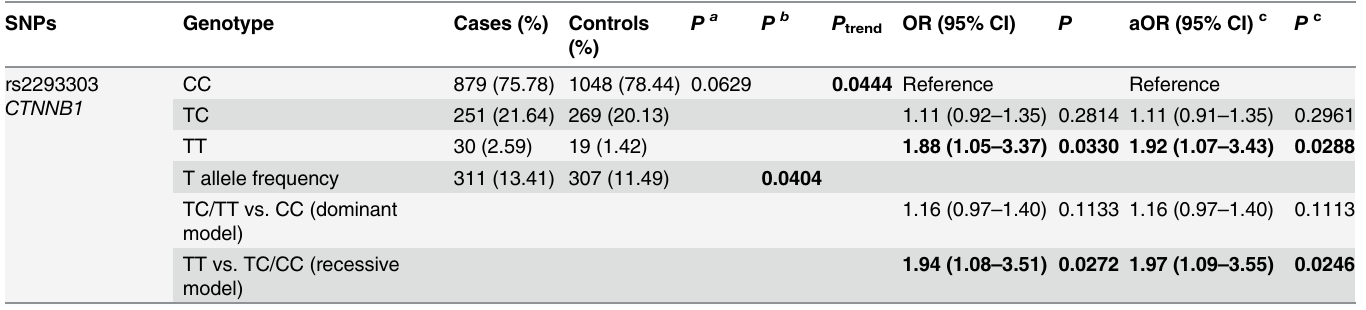
a Two-sided χ 2 test for difference in frequency distribution of genotypes between cases and controls. b Two-sided χ 2 test for difference in frequency distribution of alleles between cases and controls. c Adjusted for age at menarche, age of fi rst birth and family history of cancer in fi rst-degree relatives. Bold numbers indicate a statistical signi fi cance at 0.05 level.